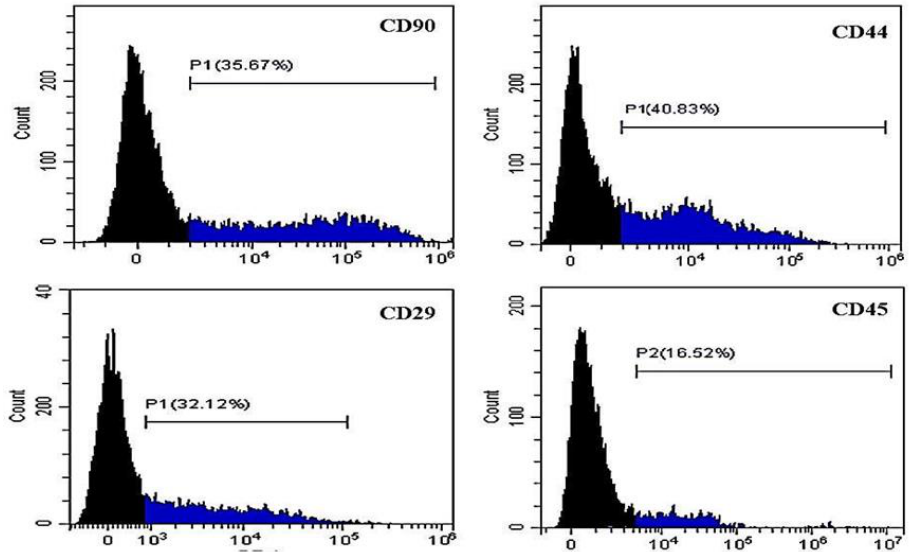
Figure 3. Results of flow cytometry assay of canine SVF cells isolated from the subcutaneous abdominal AT stained with PE-conjugated anti-CD90, anti-CD44, anti-CD29, and FITC-conjugated anti-CD45. Black areas indicate unstained cells. The percentage represents gated positive areas.